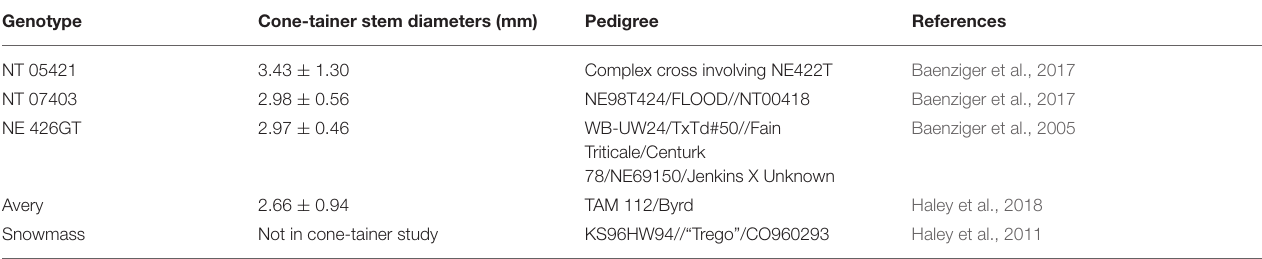
TABLE 1 | Winter triticale and wheat genotypes used in this study.